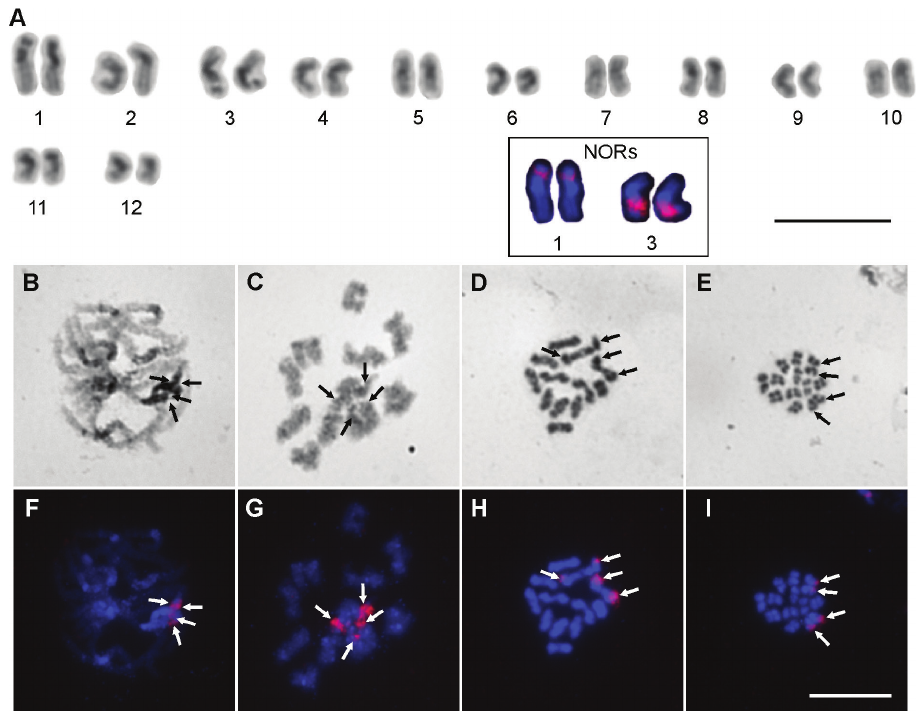
Figure 1. Chromosomes of Guruia africana (2n=24) males after Giemsa staining ( A–E ) and after FISH with 18S rDNA ( A partly, F–I ). A karyotype based on mitotic metaphase B pachytene C diplotene D diakinesis E one sister cell of metaphase II F–I are the same cells as B–E after FISH with 18S rDNA. White arrows indicate the position of 18S rDNA and black arrows indicate the same position after Giemsa staining. Bar = 10